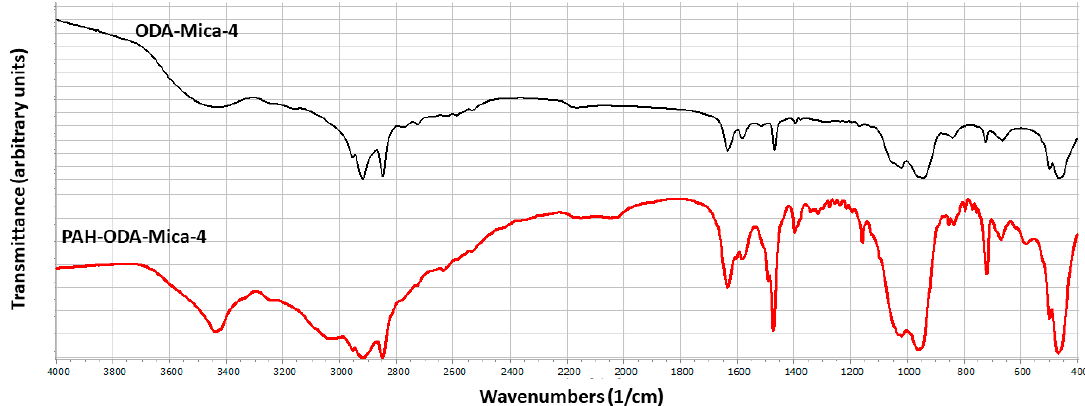
Figure 3. FT-IR transmittance spectra of ODA-Mica-4 before and after adsorption assays in 4000–400 cm − 1 region. Figure 3. FT ‐ IR transmittance spectra of ODA ‐ Mica ‐ 4 before and after adsorption assays in 4000– 400 cm − 1 region.